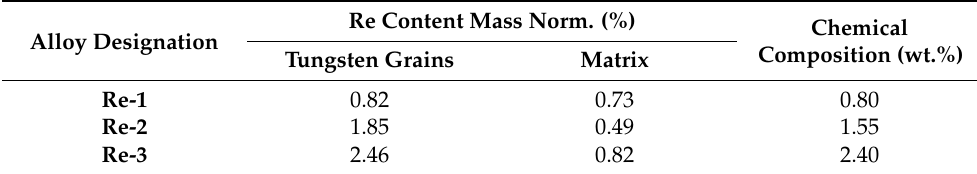
Table 6. Results of microanalysis of tungsten grains and